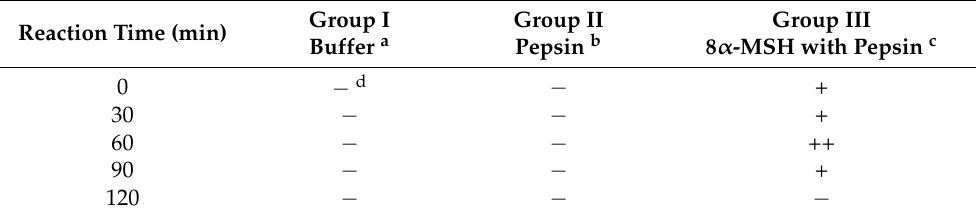
Table 3. Effect of different intervals for pepsin cleavage of 8 α -MSH. Reaction Time (min)